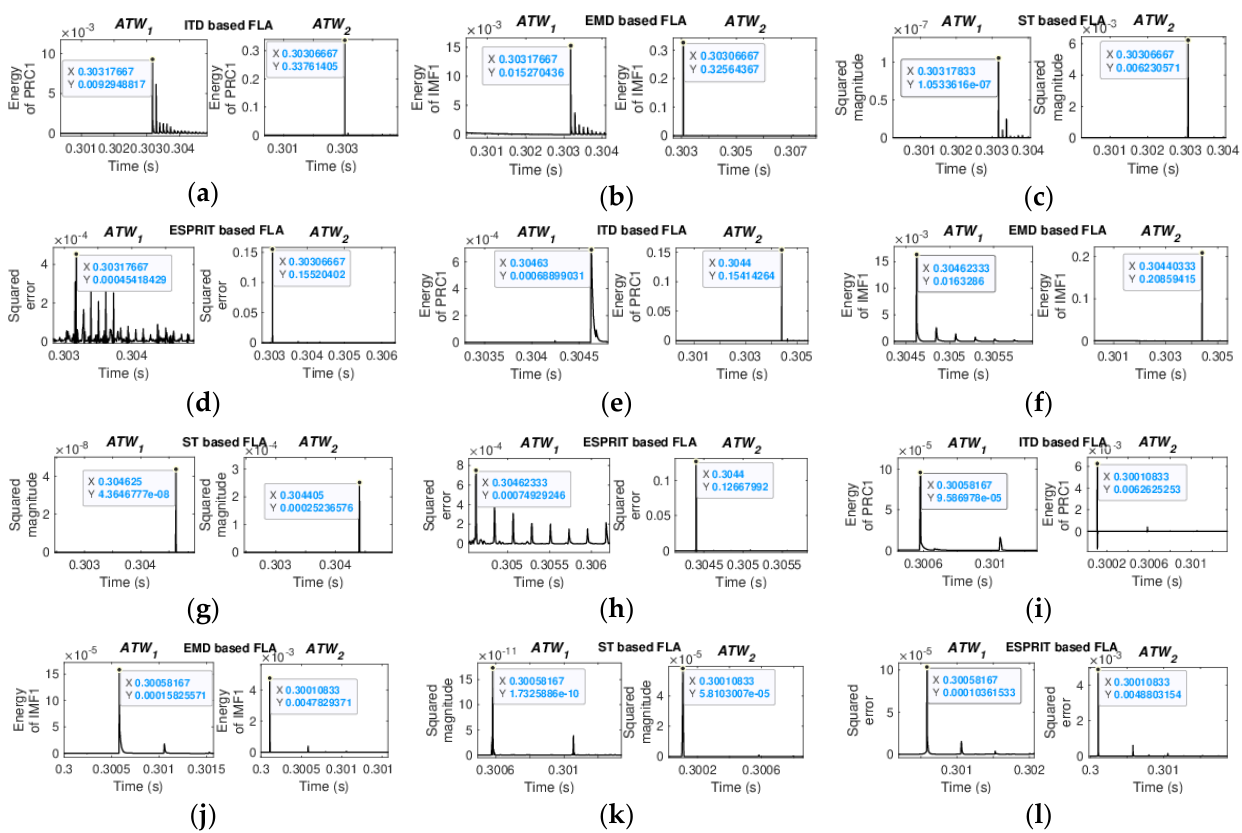
( a – d ) Estimated ATWs Scenario 1. ( e – h ) Estimated ATWs Scenario 2.